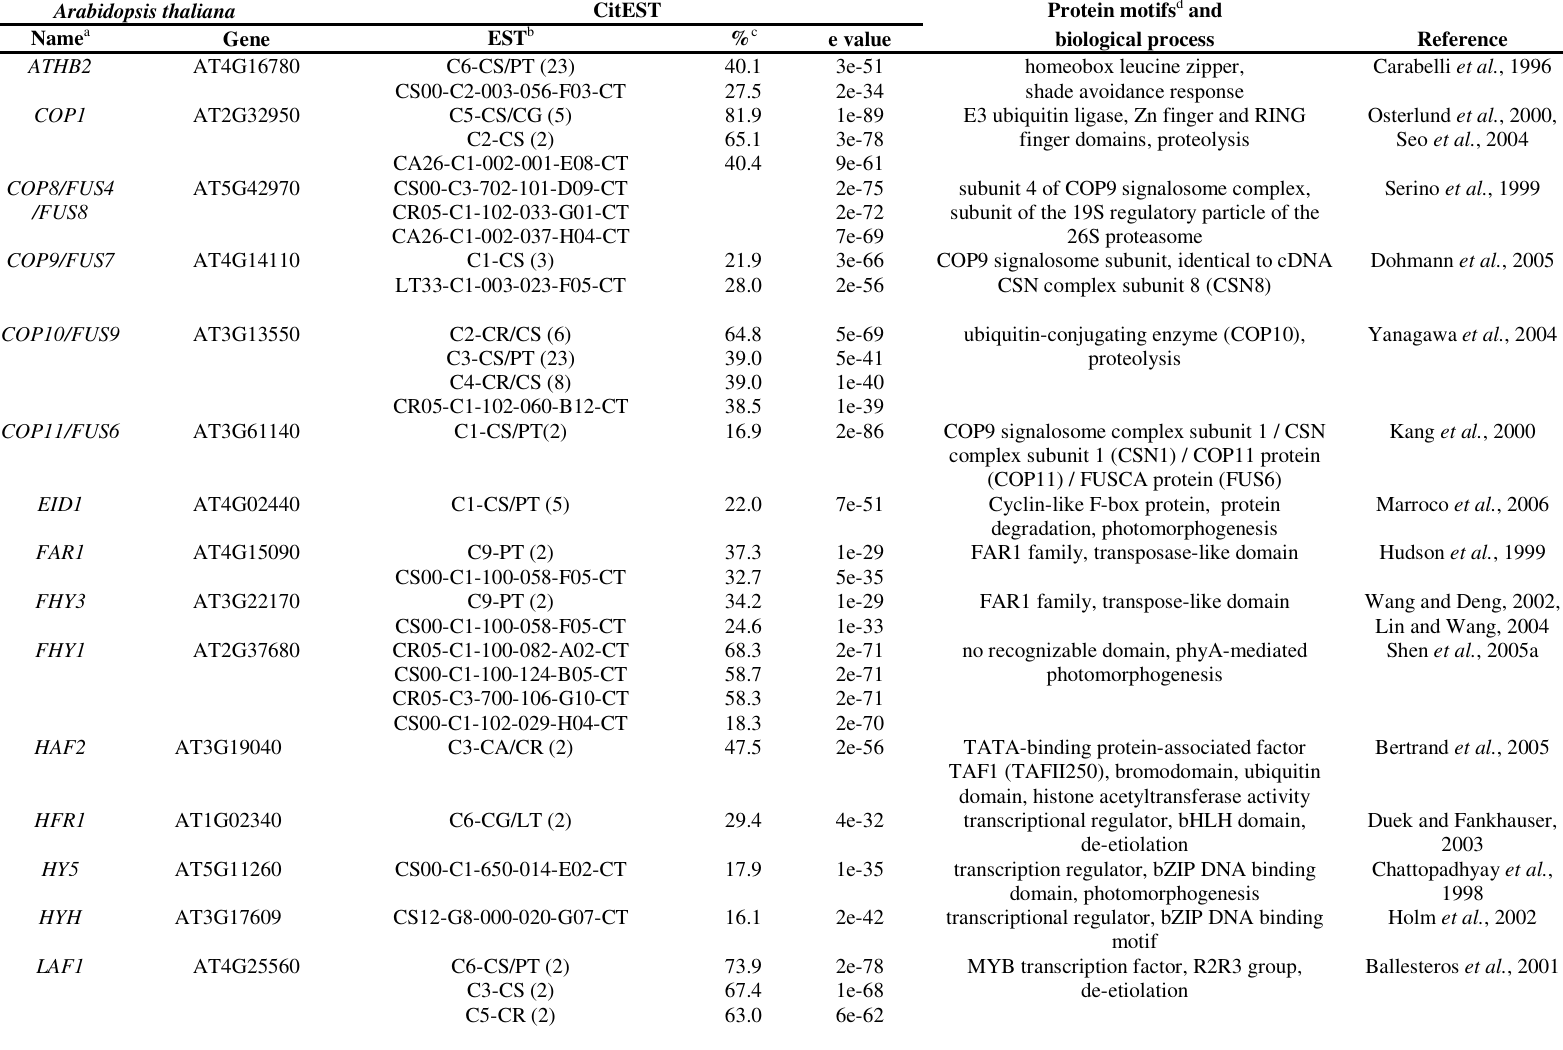
Table S2. Citrus ESTs with homology to genes involved in phytochrome- and cryptochrome-mediated responses in Arabidopsis thaliana . Arabidopsis